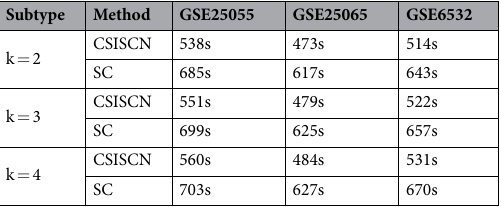
the biological difference that we observe the reality between different patient cohorts. For example, in the AML study, the training dataset GSE12417 was from a US population while the test dataset GSE10358 was from an European population. Another possible explanation is that the different class proportions between the training and the test datasets could result in the biases for clustering performance. For example, in the breast cancer study, the proportion between non-recurrence and recurrence patients is 3.7:1 in GSE25055 and 1.9:1 in GSE6532 respectively. Interestingly, this problem is popular in microarray studies with the small sample size. With increasing available gene expression data from different types of cancer, CSISCN could bridge unsuper- vised learning method and accurate subtype discovering tool for the identification of cancer molecular subtypes. In summary, CSISCN shows the great potential for the discovery of molecular subtypes for human cancers.